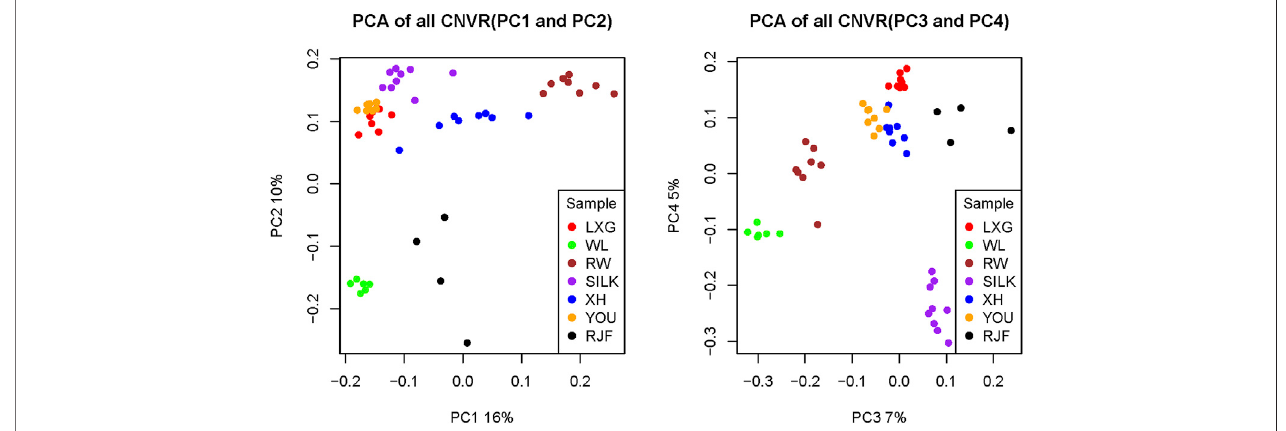
FIGURE1| Theprincipalcomponentanalysis(PCA)plotofallCNVRs. (A) Samplesweredividedintofourgroups: commerciallayer,commercialbroiler, RJFs,and Chinesenativebreeds. (B)